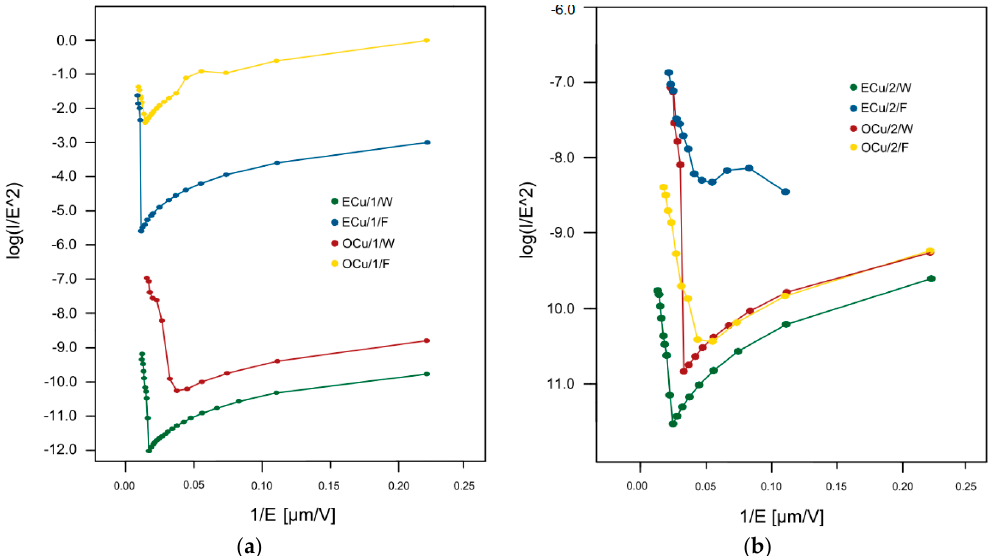
Figure 11. Fowler-Nordheim graph of the single-layered ( a ) and double-layered ( b ) samples.